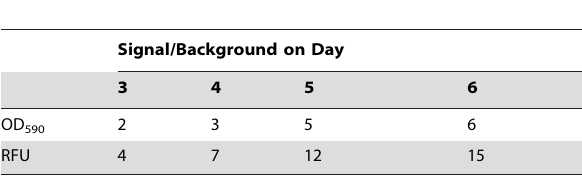
Table 1. Signal/background ratios for OD and RFU readouts.